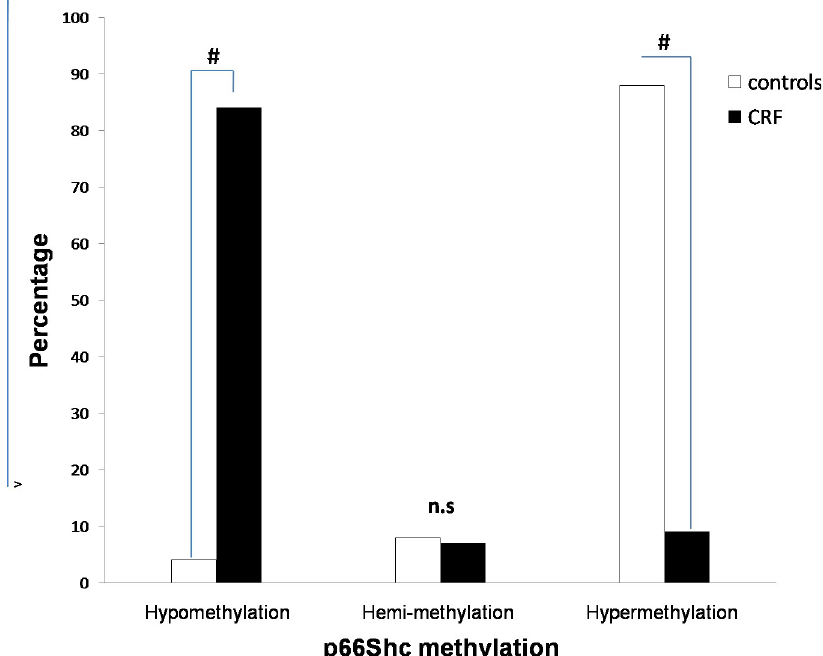
Fig 1. DNA methylation state of p66Shc promoter in CRF patients and